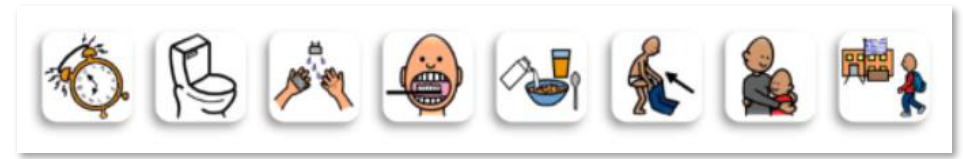
Figure 7. 8-Steps morning routine using PCS.